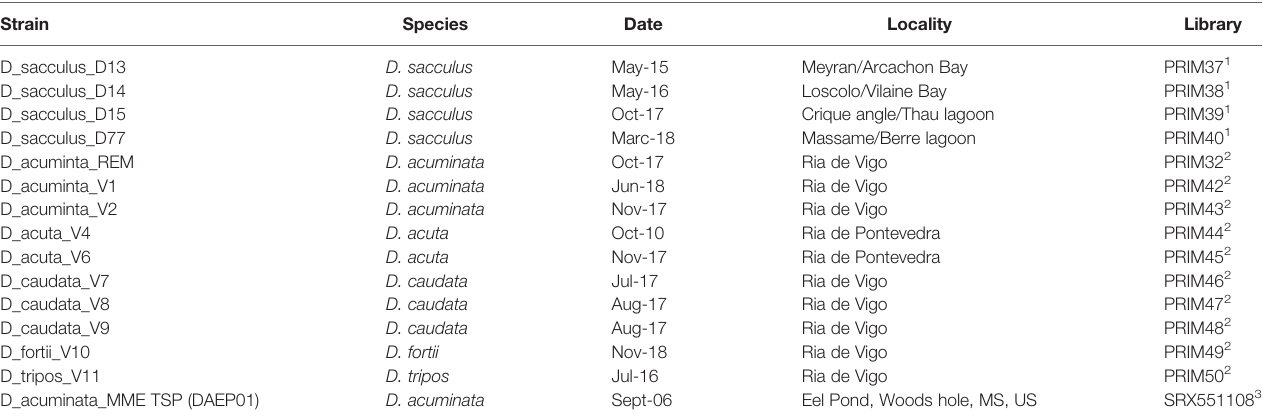
TABLE 1 | List of the Dinophysis